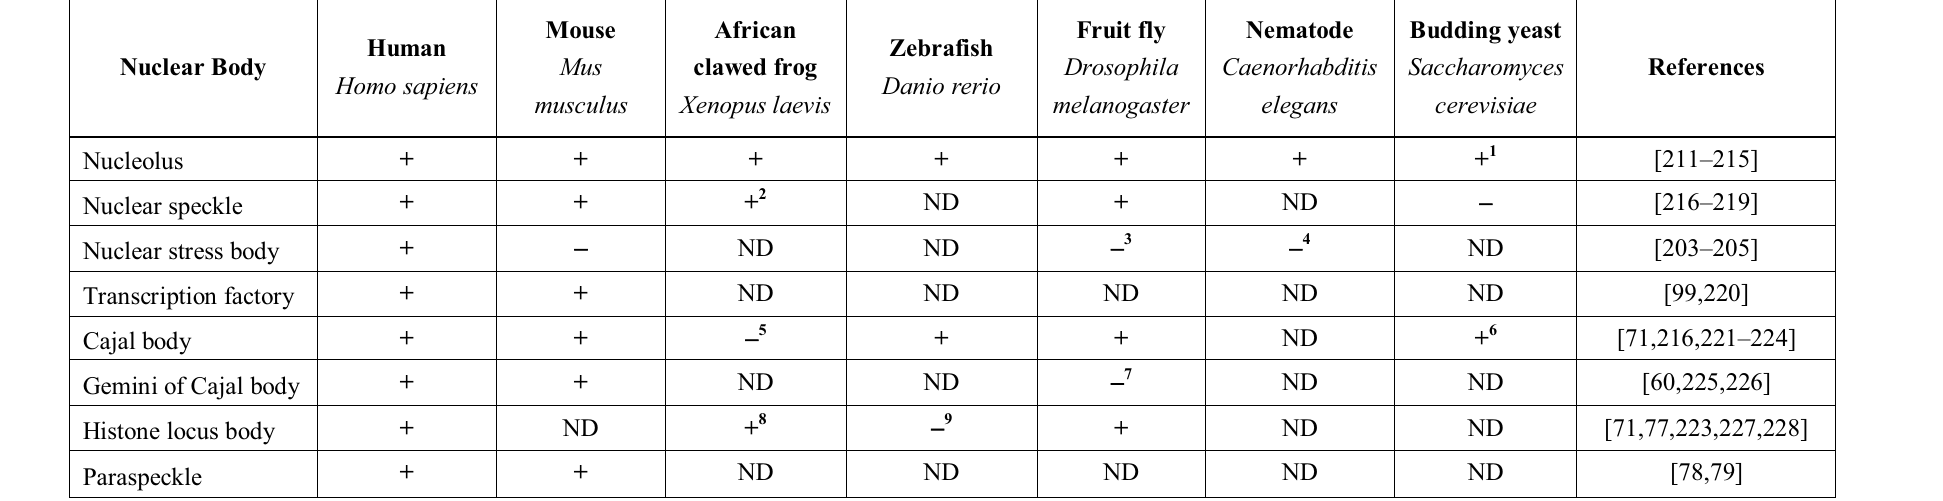
Table 4. Conservation of nuclear bodies across